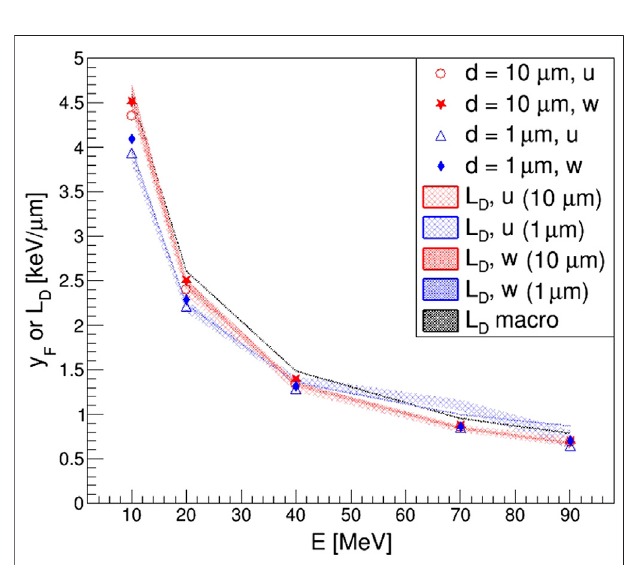
FIGURE 7 | Weighted average of the distribution of energy imparted per individualprotoncollision δ 2 asafunctionoftheprotonkineticenergy.Uniform (open markers) and weighted (full markers) random sampling results are compared for sites of 1 (blue triangles and diamonds) and 10 μ m (red circles and stars) diameter sites.